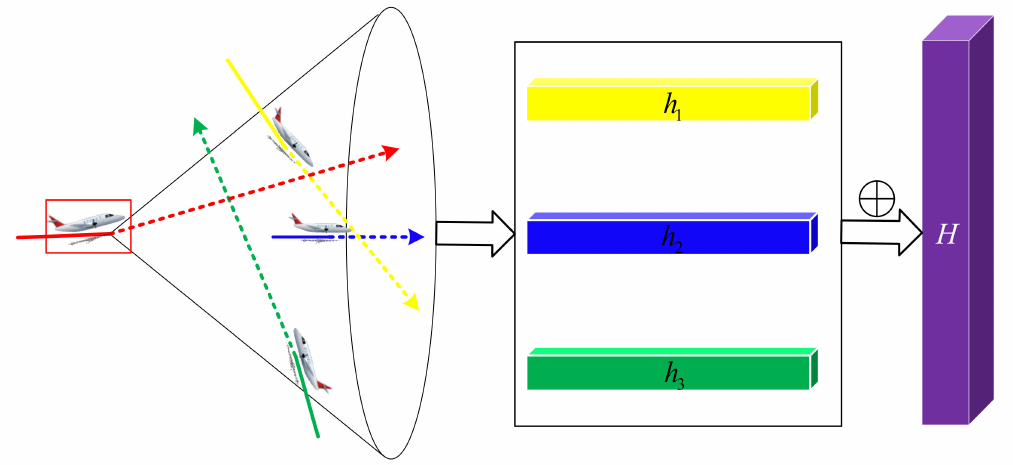
Figure 4. Pooling layer structure (take the aircraft in the red box as an